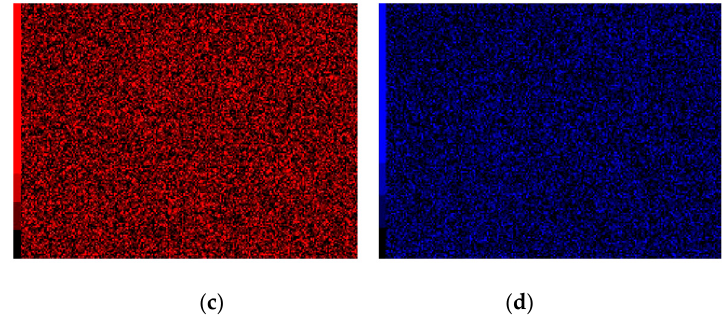
Figure 5. Plane scan analysis of 24% Cr–76% Ni coating surface. ( a ) Plane scanned position; ( b ) Plane